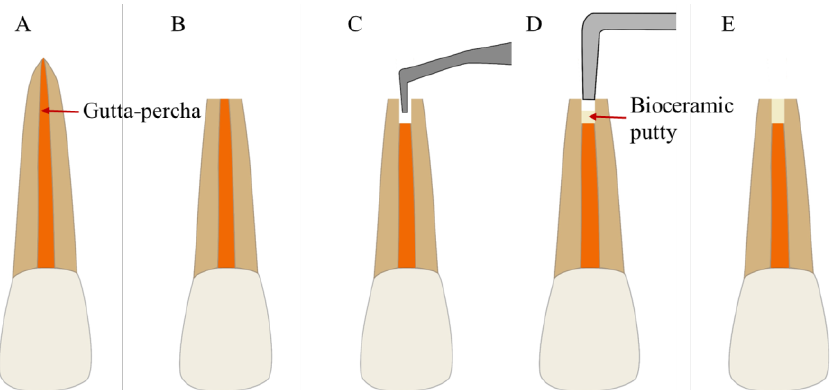
Figure 4. Treatment procedures for EMS. ( A ) A tooth with refractory periapical disease. ( B ) Root-end resection. ( C ) Root-end preparation. ( D ) Root-end filling with bioceramic putty. ( E ) Complete root-end filling.